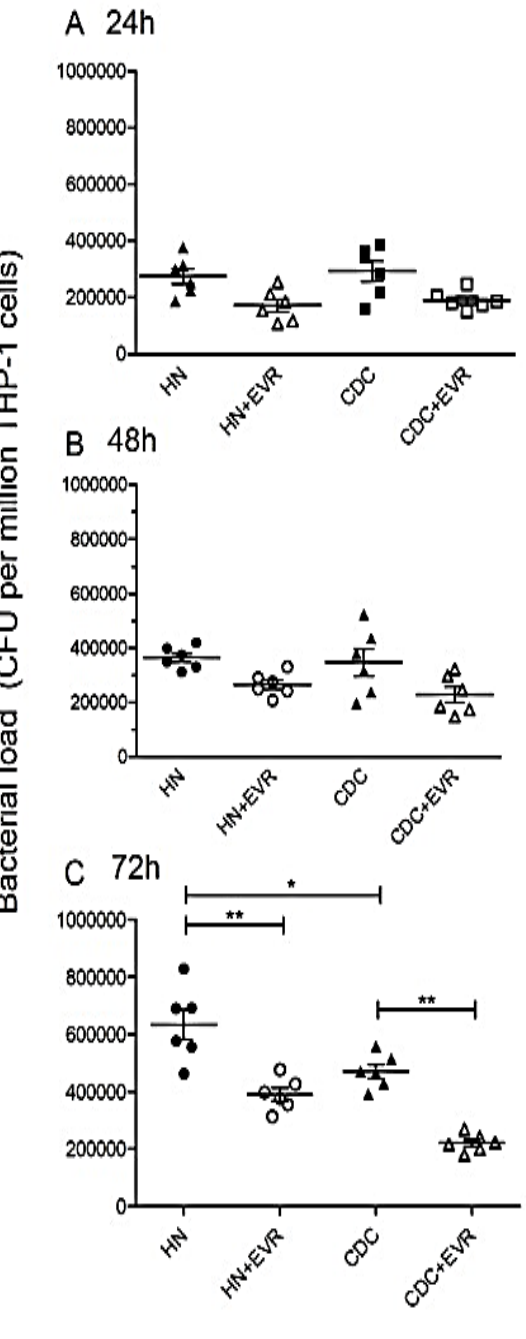
Figure 2: Survival of M.tb in THP-1 cells . THP-1 cells were infected in vitro with CDC 1551 and HN878 strains of M.tb. Infected THP-1 cells were either untreated (control) or treated in vitro with everolimus (0.5 mg/ml). Infected macrophages were terminated at 24h (Figure 2A), 48h (Figure 2B) and 72h (Figure 2C) post-infection. Cell-free supernatants were collected and stored. Granulomas were lysed with ice-cold PBS. Supernatants and granuloma lysates were plated on 7H11 agar plates containing ADC to determine the survival of M.tb